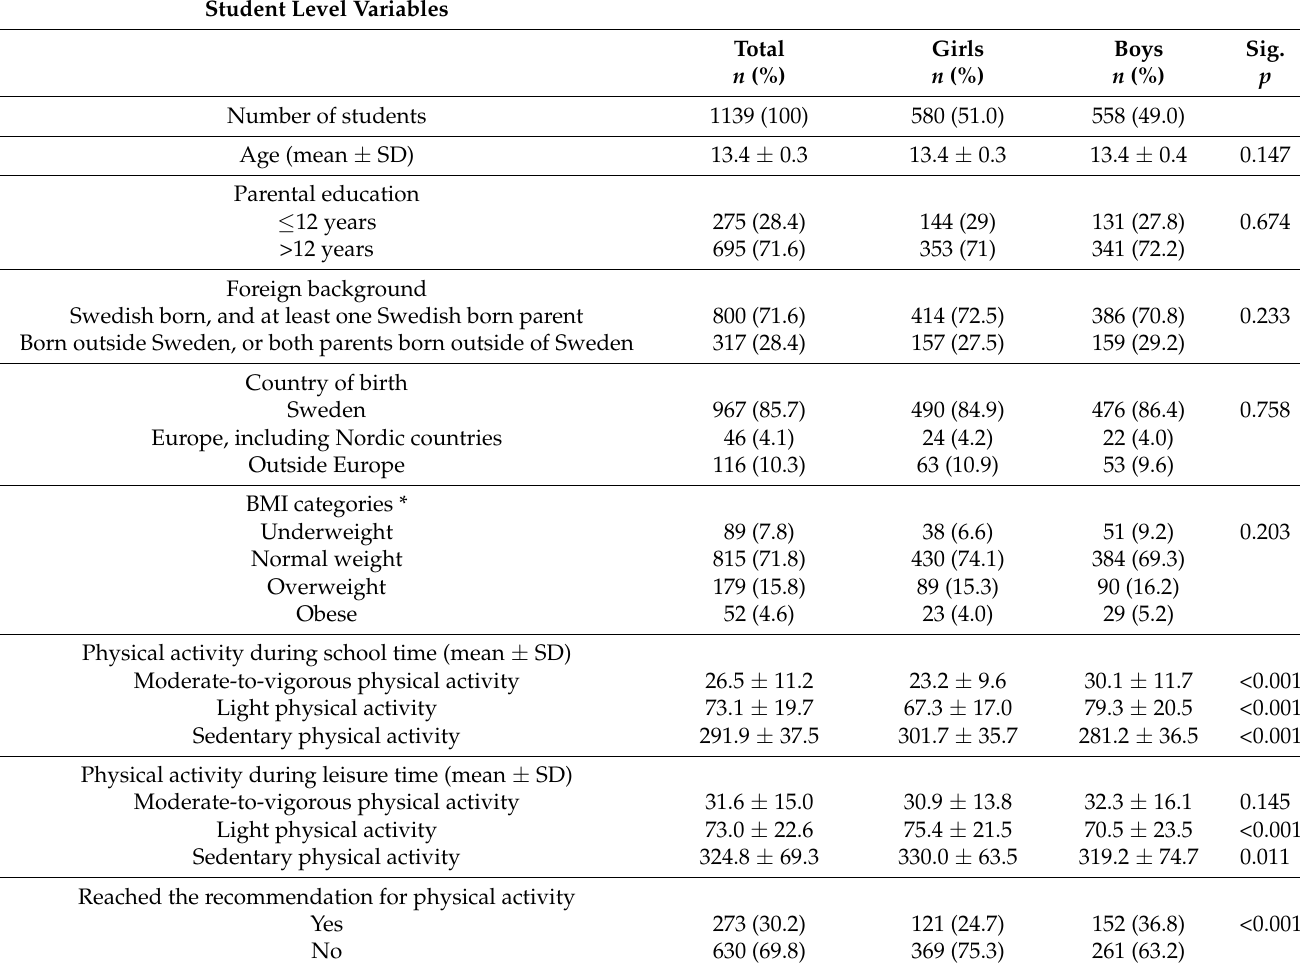
Table 1. Descriptive statistics for the students and the